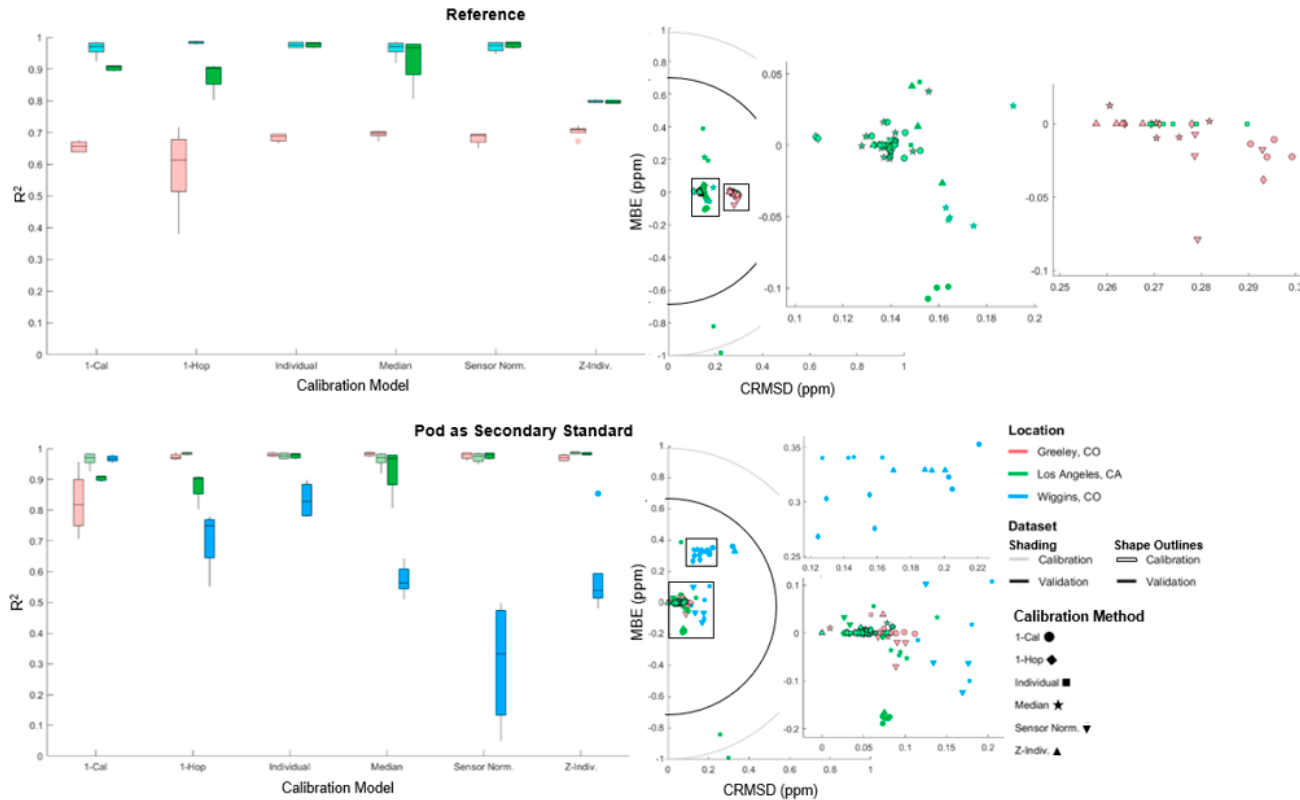
Figure 4. R 2 ( left ) and MBE vs. CRMSD target plot ( right ) for all sensor signal normalization and multi-pod calibration approaches studied for methane against: a reference-grade instrument ( top ); a pod as a secondary standard ( bottom ). The box-and-whiskers are each in the following order from left to right: Greeley calibration, Los Angeles calibration, Los Angeles validation, Wiggins validation* (* bottom only).